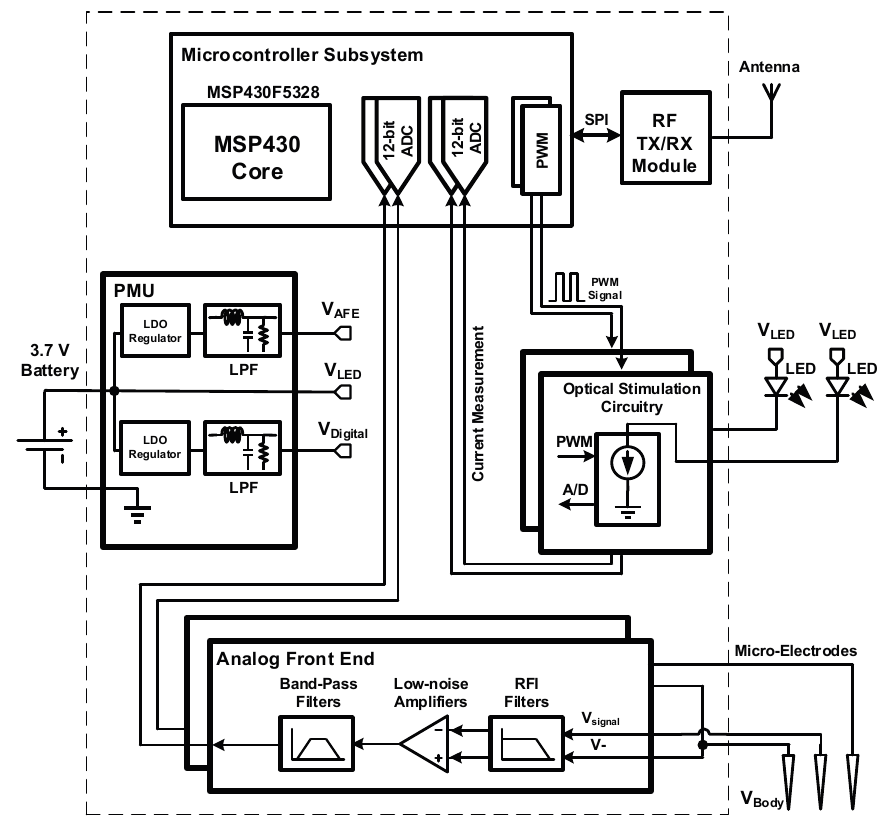
Figure 1. Block diagram of the proposed headstage